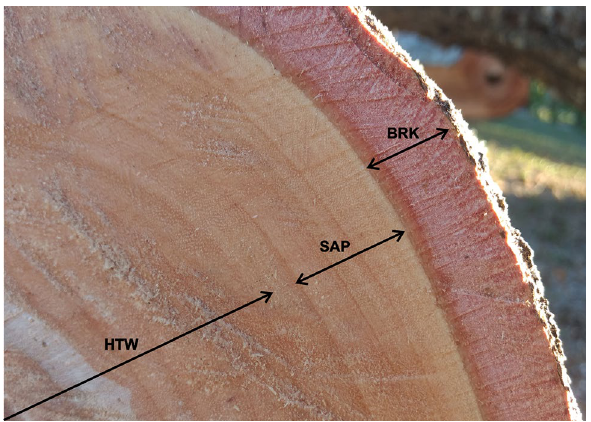
Figure 2. Main macroscopic layers observed in Pterogyne nitens wood: bark (BRK); sapwood (SAP); heartwood